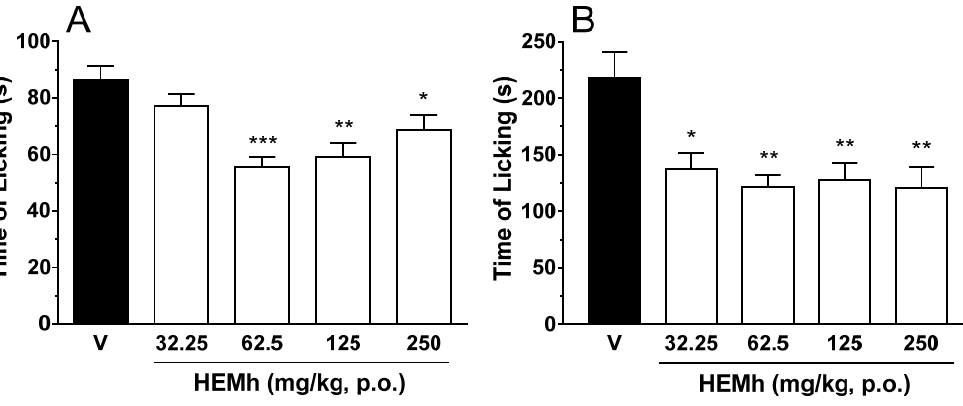
Figure 4. Effect of different doses of hydroalcoholic extract of the twigs of Machaerium hirtum (HEMh) in the formalin test (panel A —neurogenic phase and panel B —inflammatory phase). Each column represents the mean obtained from the 6–10 animals in each group (V = vehicle and different doses of HEMh), while the vertical lines indicate the S.E.M. The asterisks denote the significance levels compared with the control group. * p < 0.05, ** p < 0.01 and *** p < 0.001 calculated using one-way ANOVA (analysis of variance) followed by Dunnett’s test.